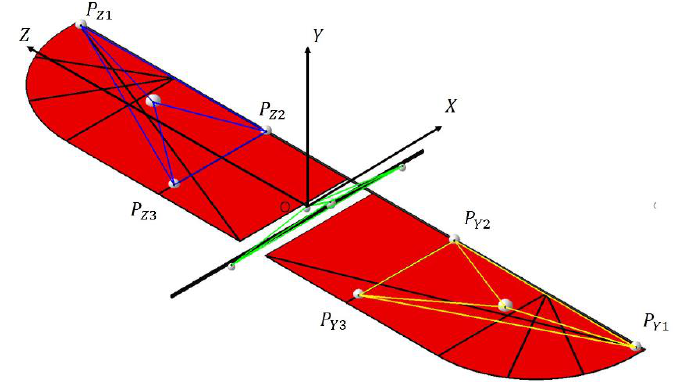
Figure 8. The wing and reflective balls in the body coordinate system.